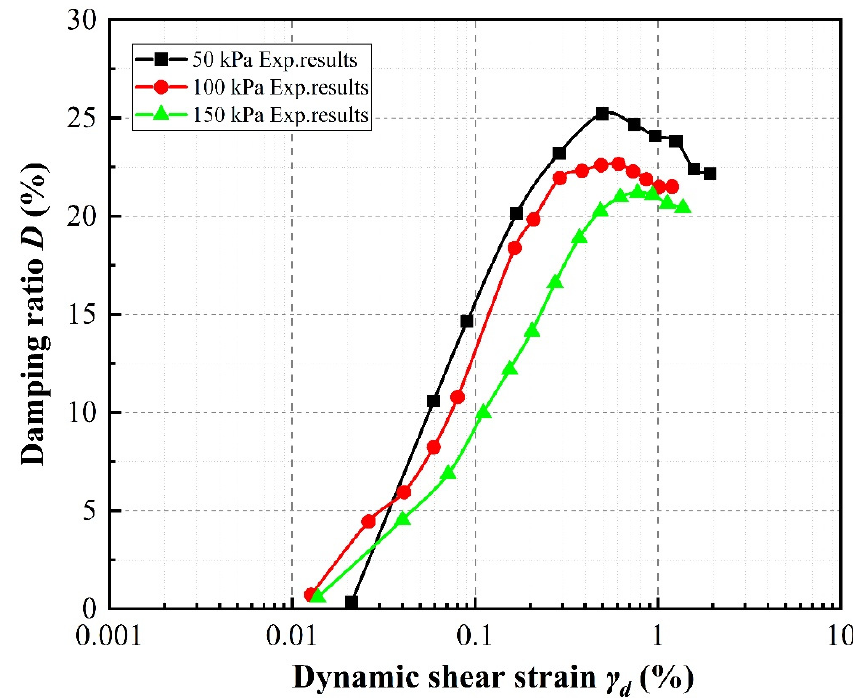
Figure 14. Effect of confining pressure on damping ratios of SRP2 sand–rubber mixtures with 20% rubber volume content.